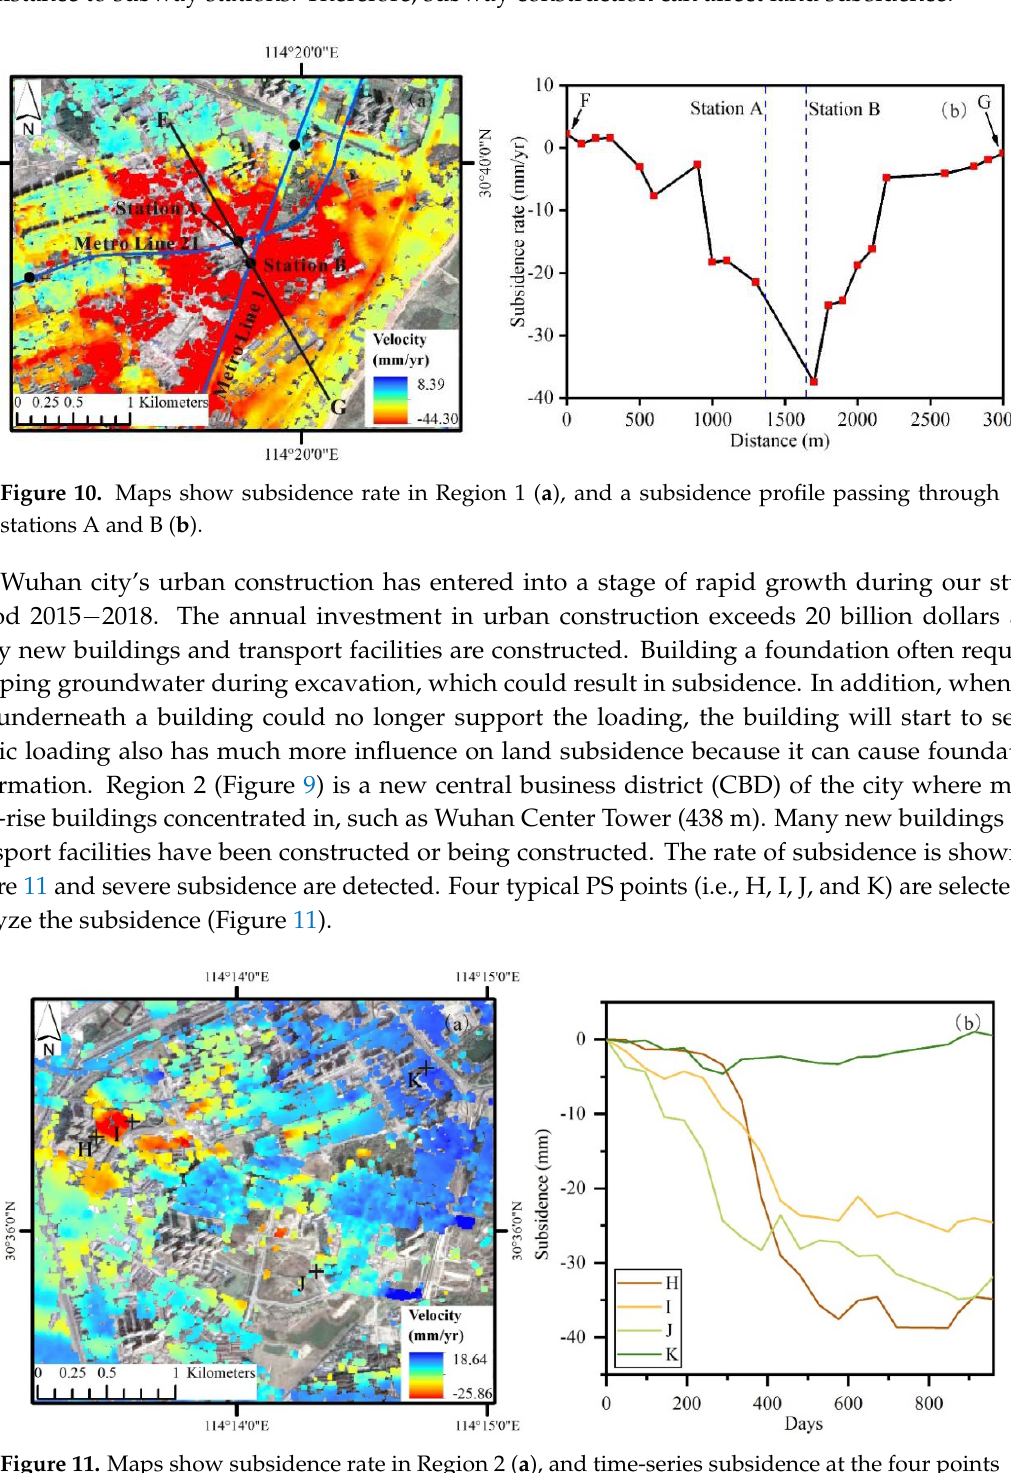
Figure 12. Maps show the satellite images of Region 2 on 21 January 2015 (a) and 9 December 2017 (b) .